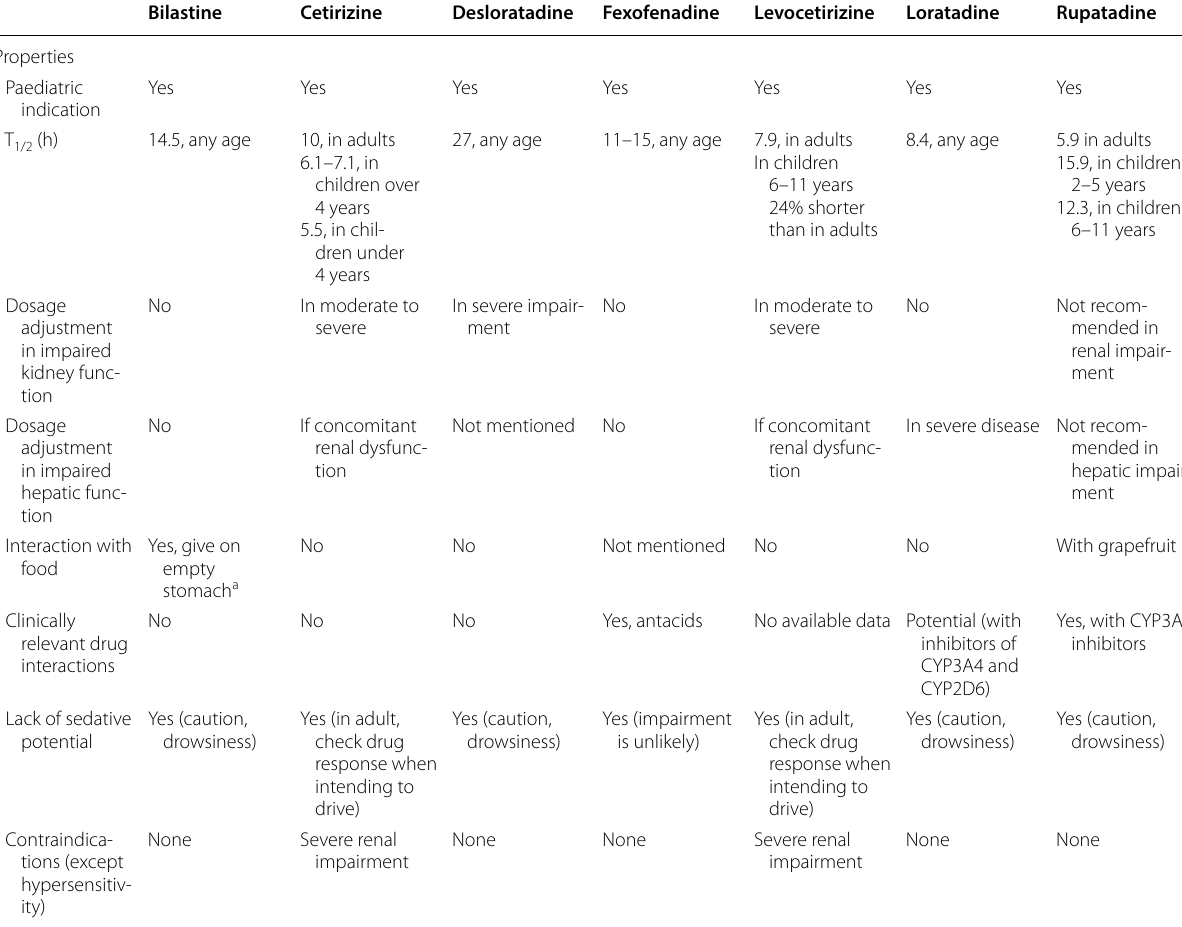
Table 1 Safety profile of representative second generation H from